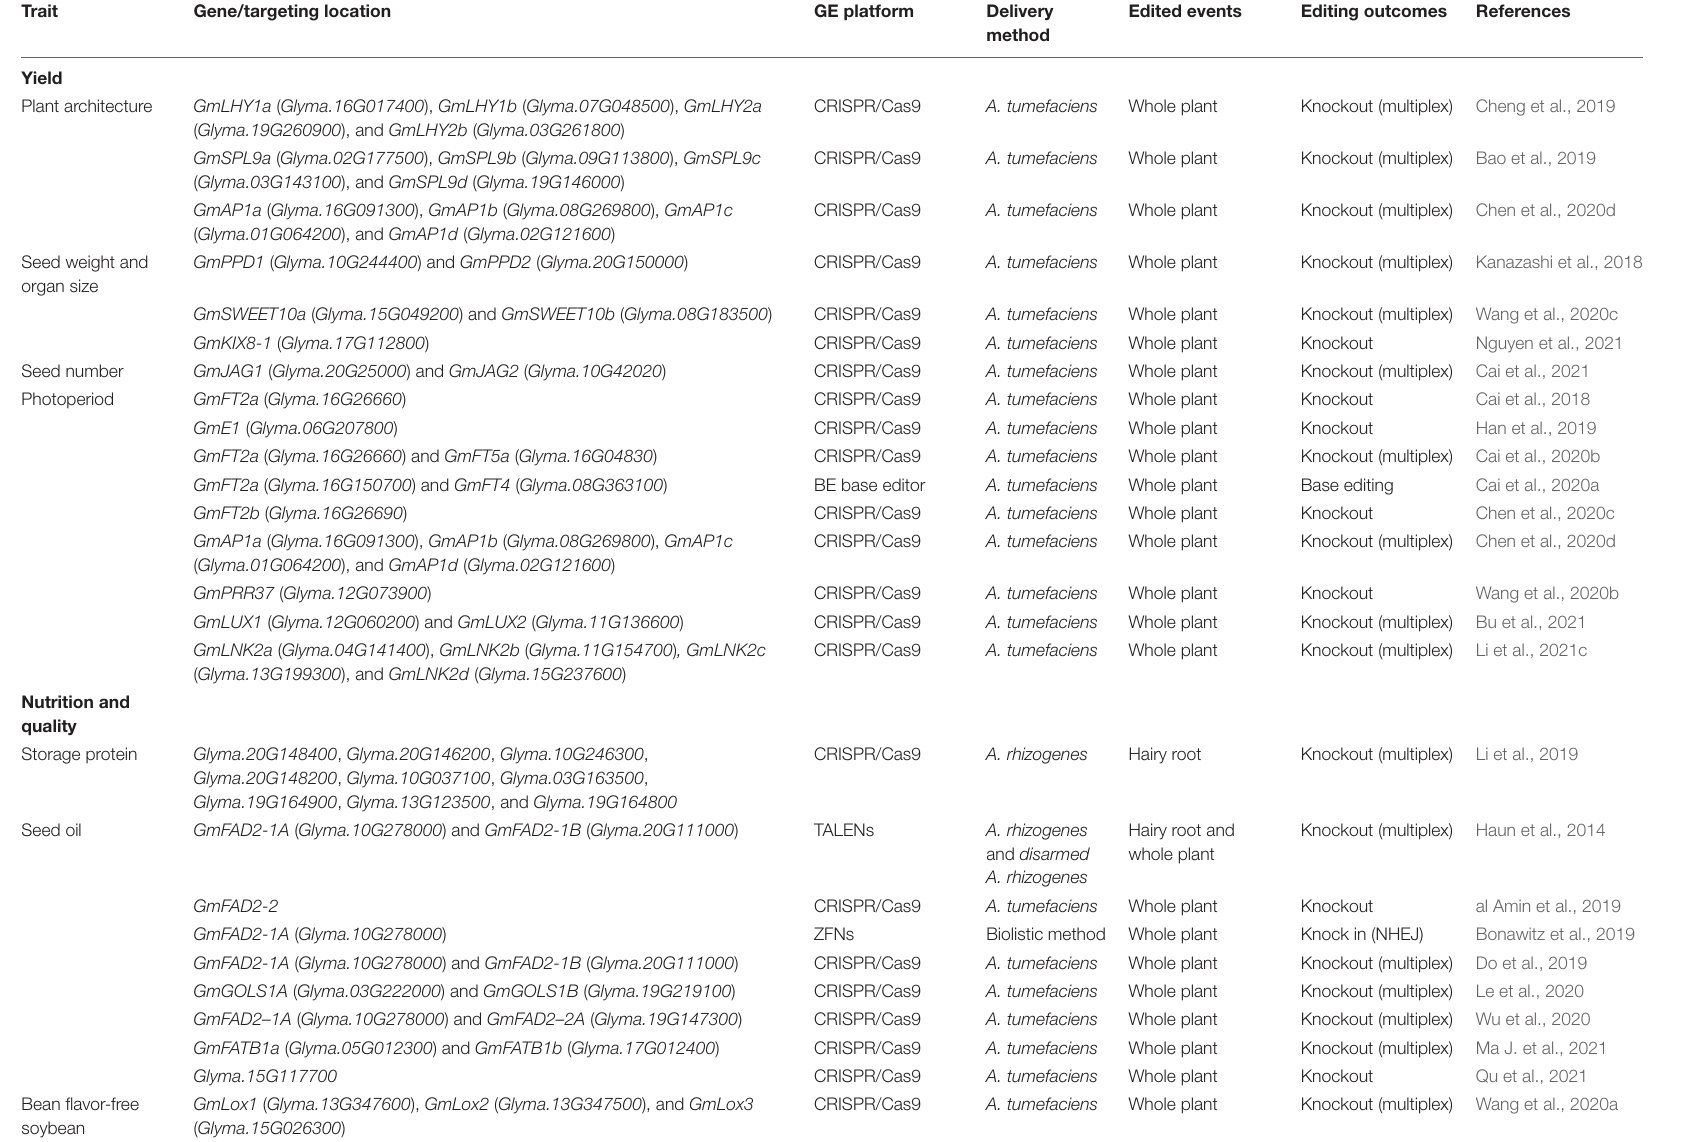
TABLE 3 | List of soybean genes edited for functional genetics study and trait improvement using genome editing technology.